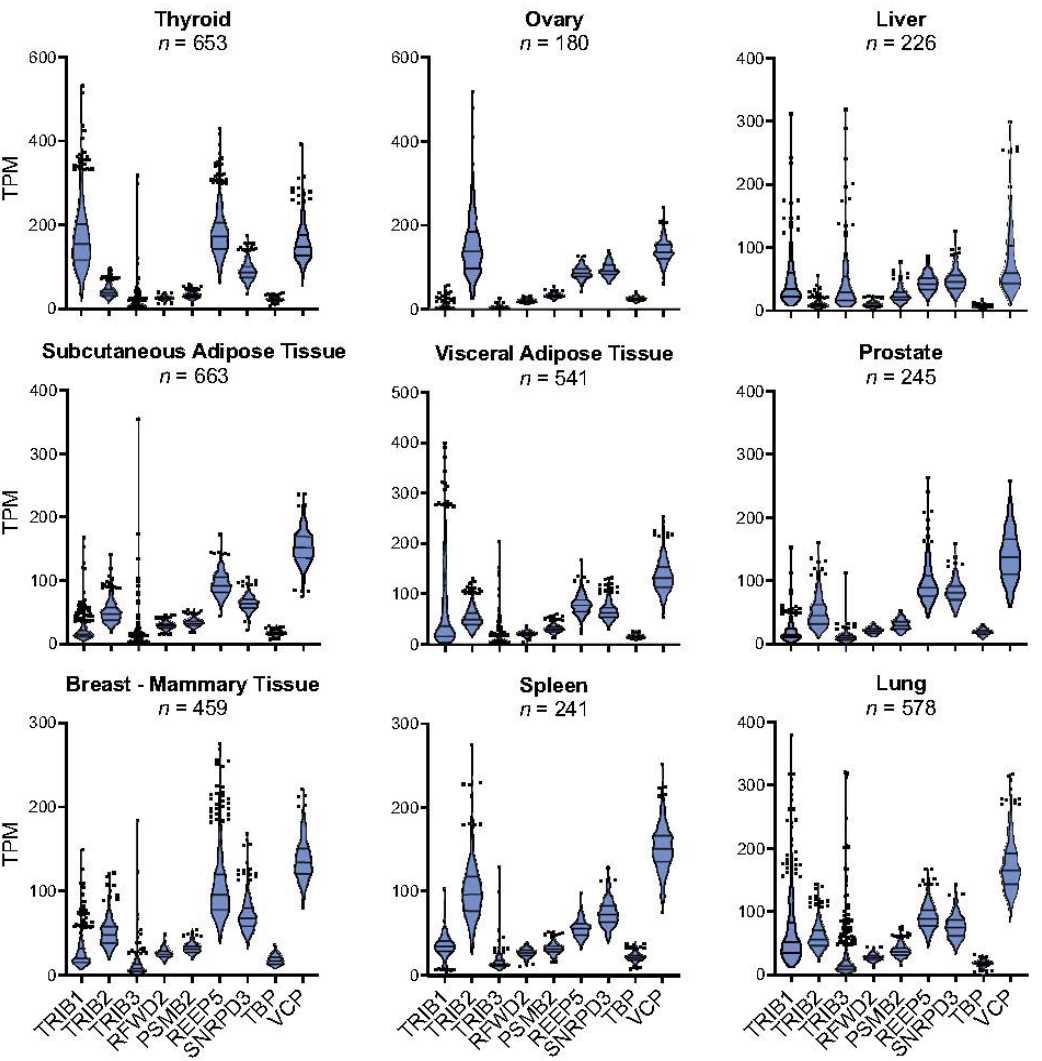
Figure 1. Violin plots of RNA-sequencing data from GTEx consortium (v8) [37] in a selection of tissues. Horizontal lines indicate median, 25th and 75th percentile values; black dots represent values >1.5 × the interquartile range below or above these values. TPM = transcripts per million. PSMB2 = proteasome subunit beta 2; REEP5 = receptor accessory protein 5; SNRPD3 = small nuclear ribonucleoprotein D3; TBP = TATA-box binding protein; VCP = valosin-containing protein.